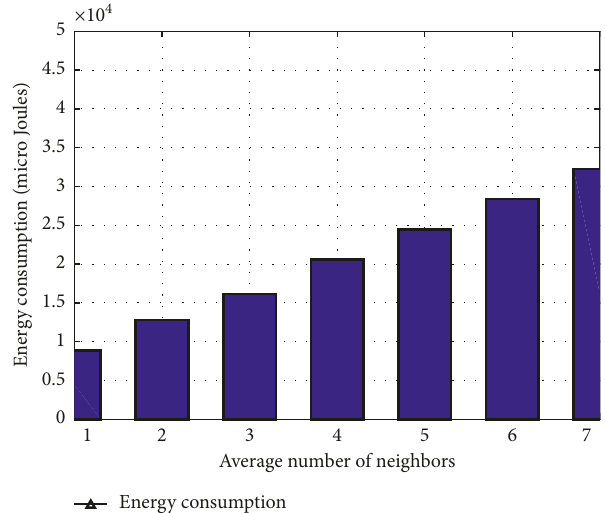
Figure 8: Energy consumption in a clustered